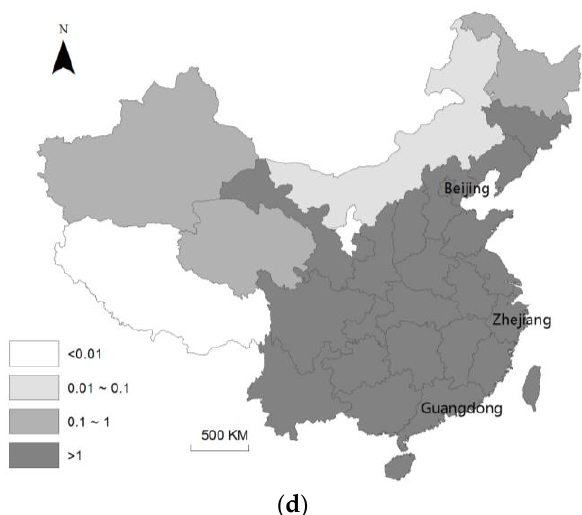
Figure 11. ( a ) The distribution of the number of Weibo posts per million people in China (Week 1— 1 to 7 June 2014); ( b ) The distribution of the number of Weibo posts per million people in China (Week 14—31 August to 6 September 2014); ( c ) The distribution of the number of Weibo posts per million people in China (Week 17—21 to 27 September 2014); ( d ) The distribution of the number of Weibo posts per million people in China (Week 21—19 to 26 October 2014).